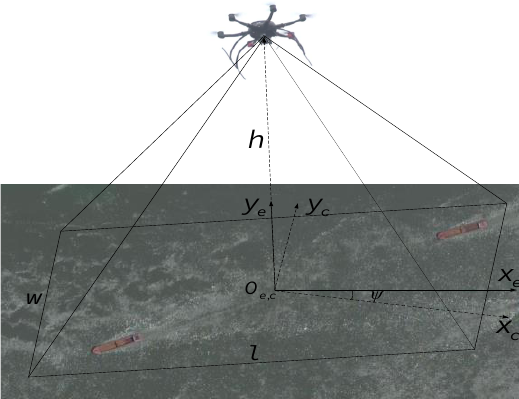
Figure 10. The camera and earth coordinates.